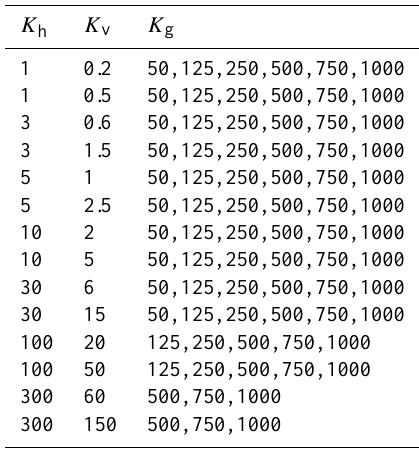
Table 1. The stochastic spatial analysis is performed for various combinations of the horizontal hydraulic conductivity, K h , the ver- tical hydraulic conductivity, K v , and the gravel pack hydraulic con- ductivity, K g . All values are in units of [md − 1